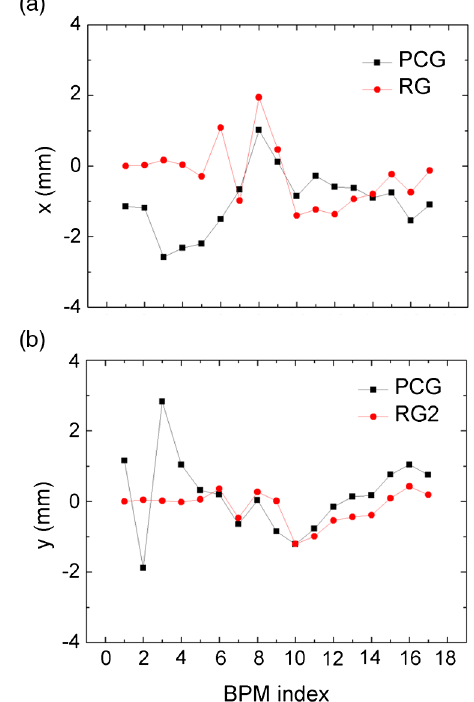
(unpublished).FIG. 9. (a) Horizontal and (b) vertical beam trajectories for PCG and RG2 beam at the same corrector set